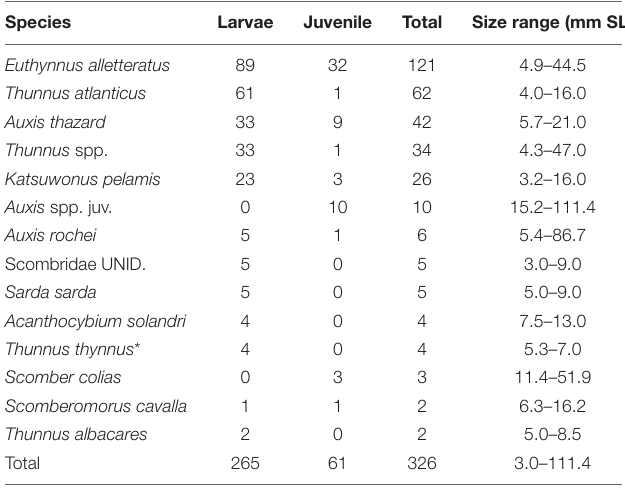
TABLE 1 | Counts and size range of scombrid specimens caught in quantitative tows from the surface to 1500 m